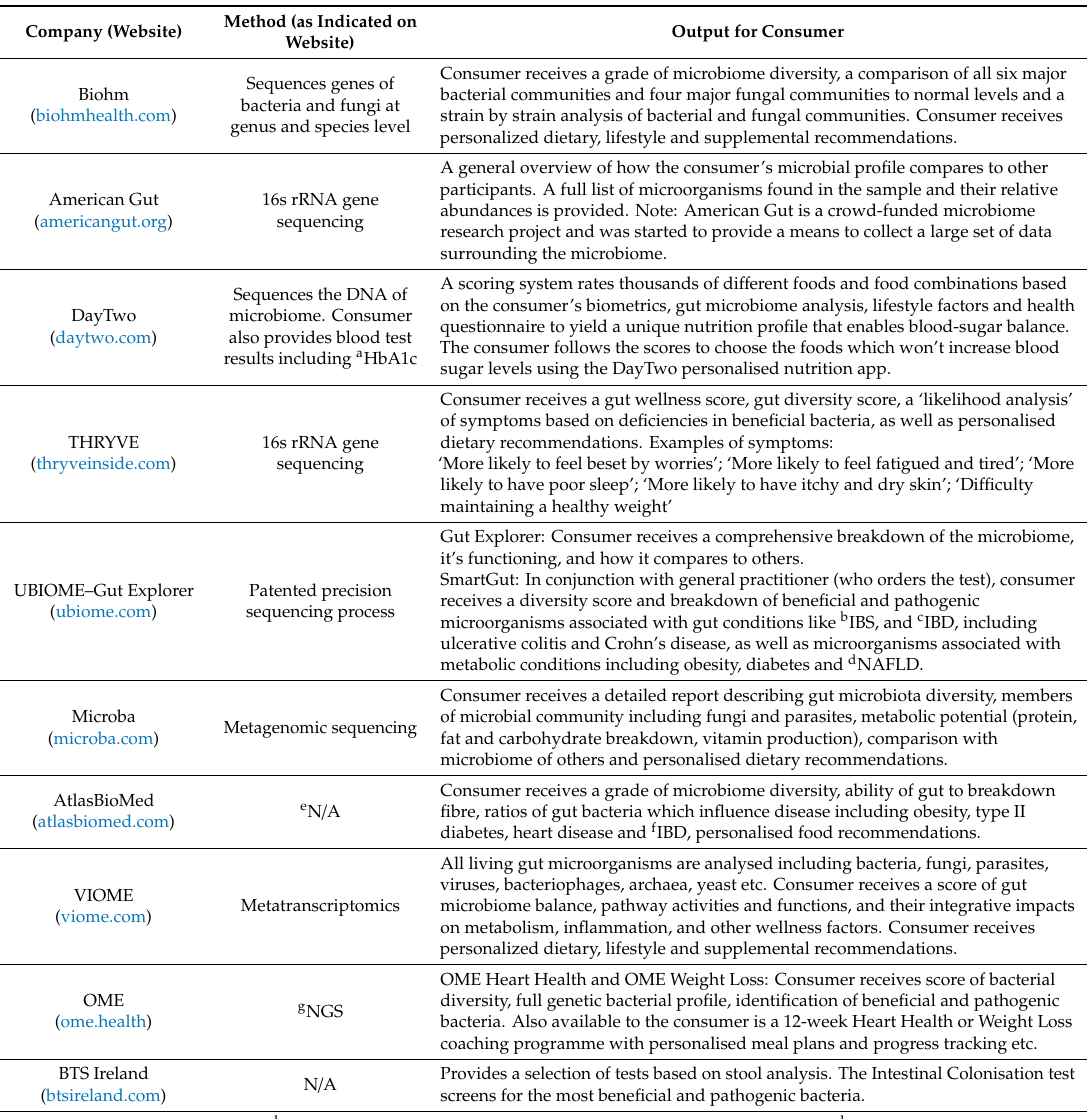
Table 5. List of companies that o ff er gut microbiome